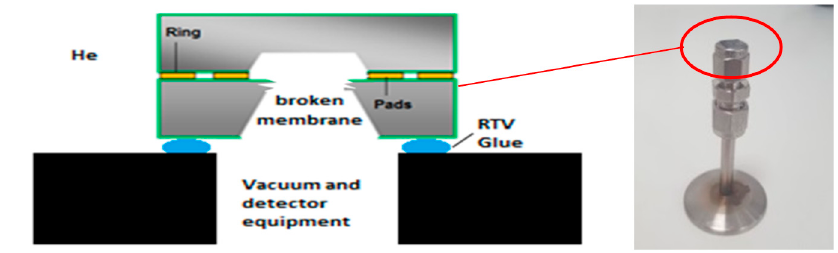
Figure 5. He Hermiticity test on structure 2.